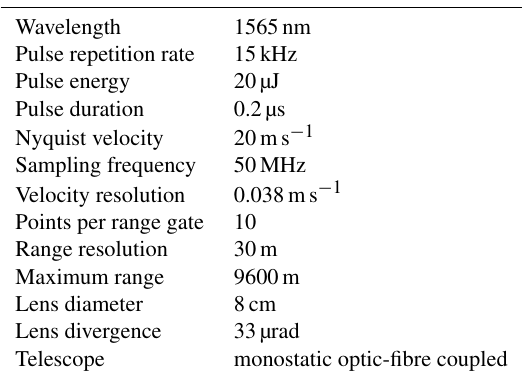
Table 1. Specifications of Halo Doppler lidars used in this